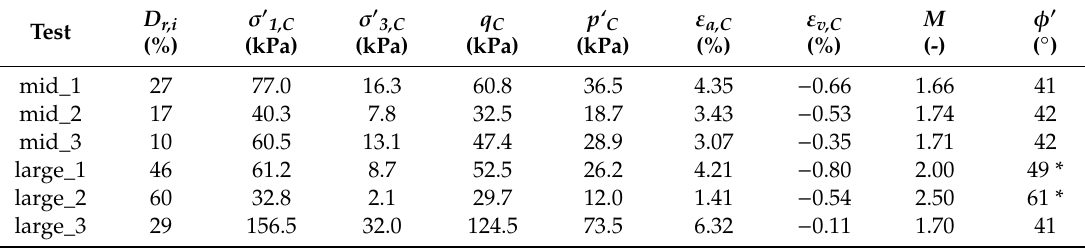
Table 6. Summary of constant shear stress drained (CSD) triaxial stress path test results at failure from an adopted grain size distribution (GSD) of the gravelly